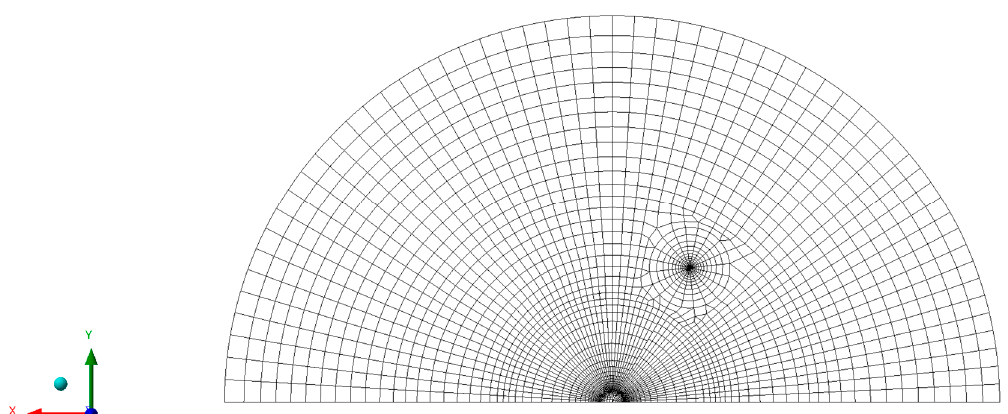
Figure 3. Mesh of the specimen modeled with the finite element analysis (FEM) software.